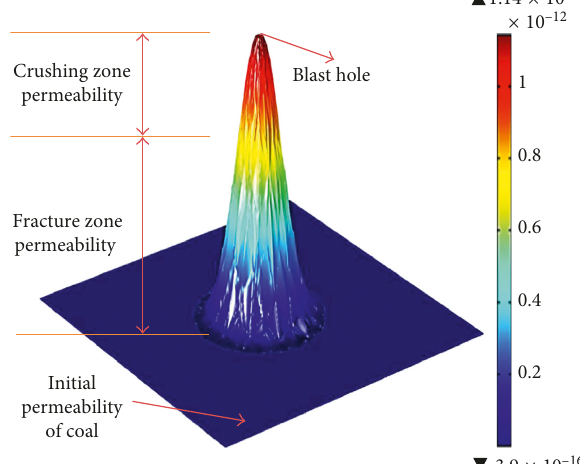
Figure 11: Coal permeability changes after the